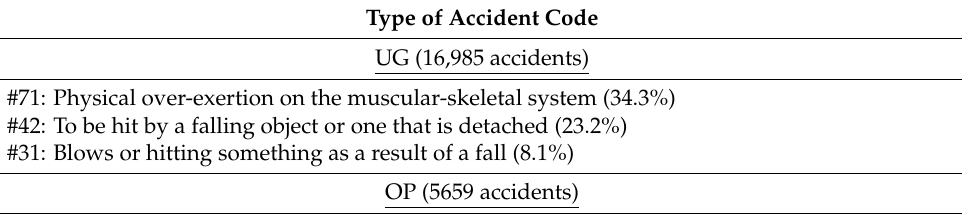
Table 1. Distribution per type of accident recorded in the UG, OP and PP.